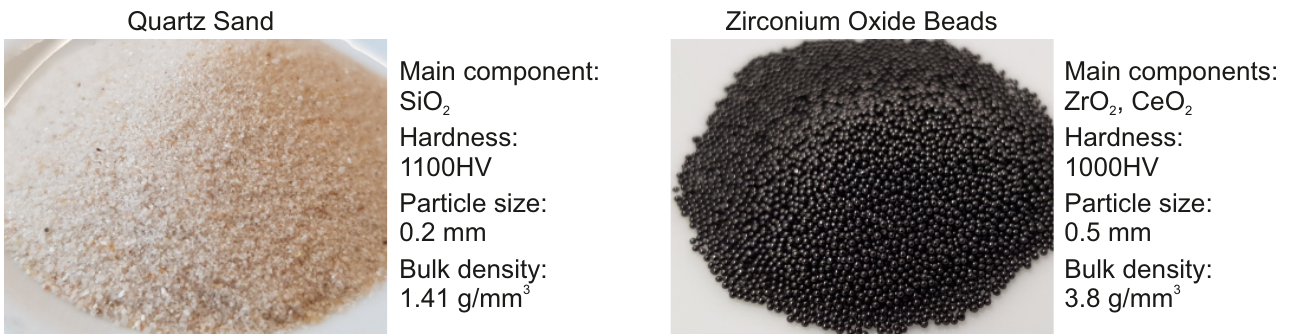
Figure 11. Granular media used as lost cores in cold forging.